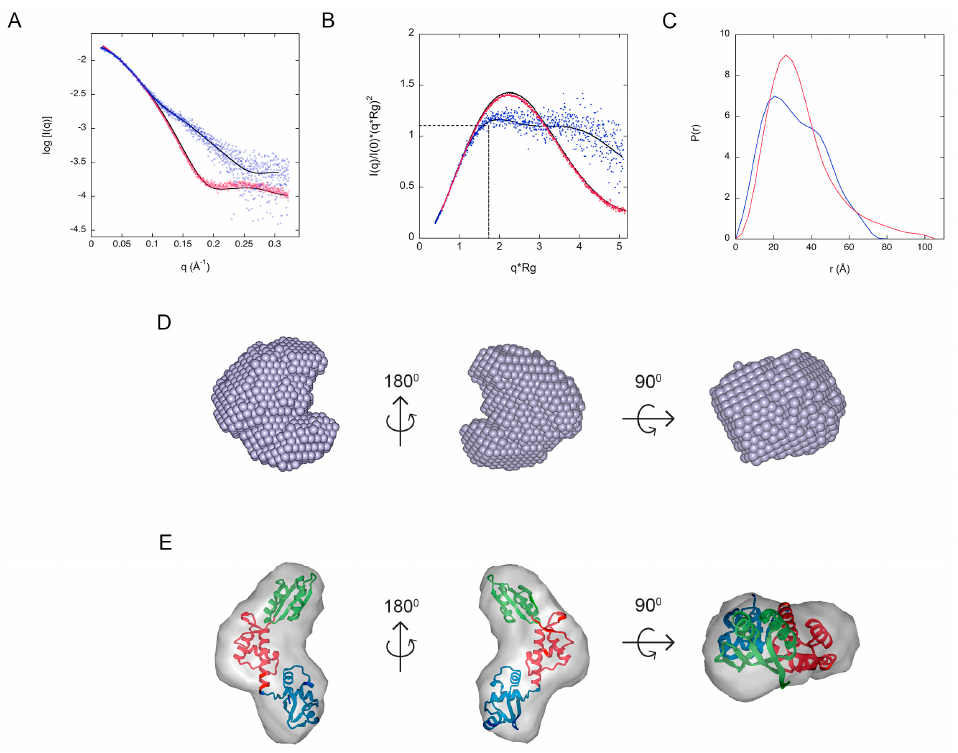
Figure 3. SAXS data for Bcp1 (blue) and AfSBDS (red). ( A ) Fit of the simulated scattering curves compared to the observed scattering signal. ( B ) Dimensionless Kratky plot of the experimental data and simulated scattering shown in A. The intersection of the dotted black trace corresponds to the value for BSA. ( C ) Pair distribution function plot. ( D ) Ab initio molecular envelope of Bcp1. ( E ) Ab initio molecular envelope of AfSBDS showing the fitting of the crystallographic model.